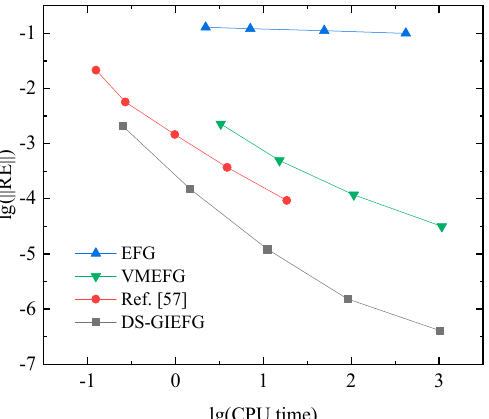
Figure 9. The variation of relative errors of different methods with respect to the node spacing (in lg–lg scale).